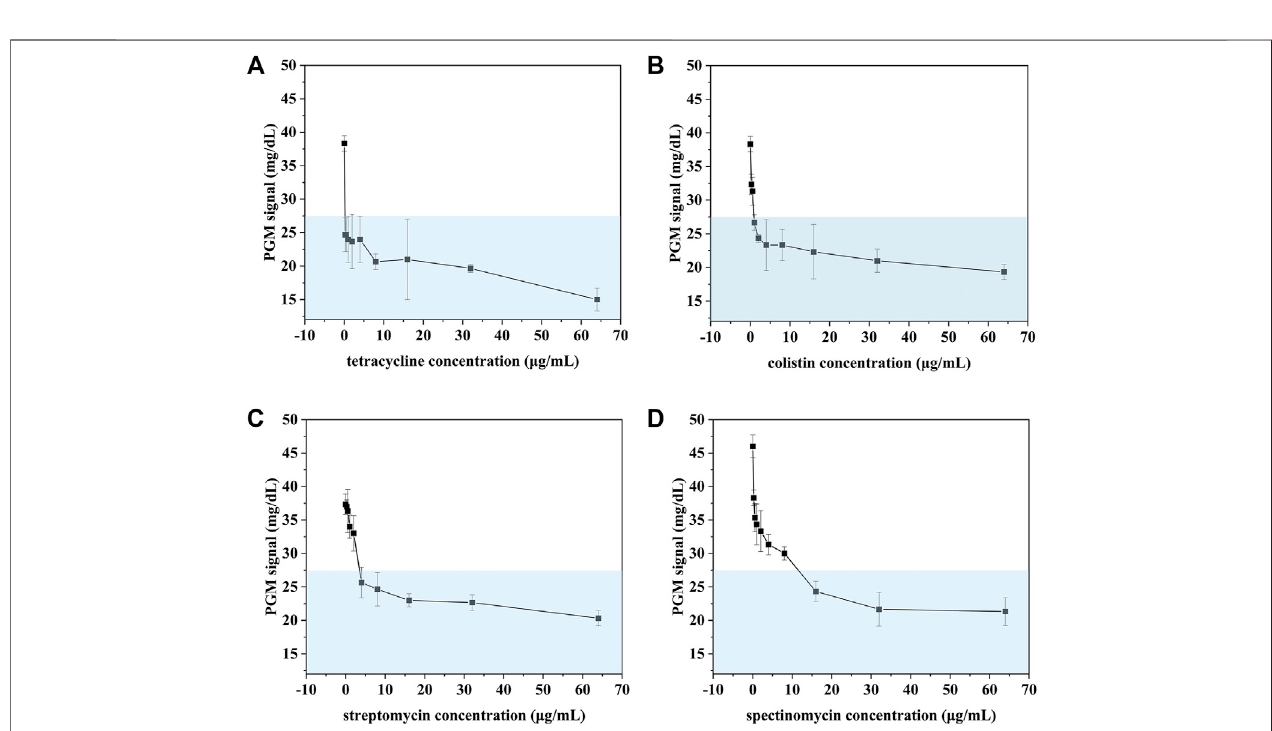
FIGURE 7 | AST of E. coli treated with tetracycline (A) , colistin (B) , streptomycin (C) , spectinomycin (D) detected using our proposed method.